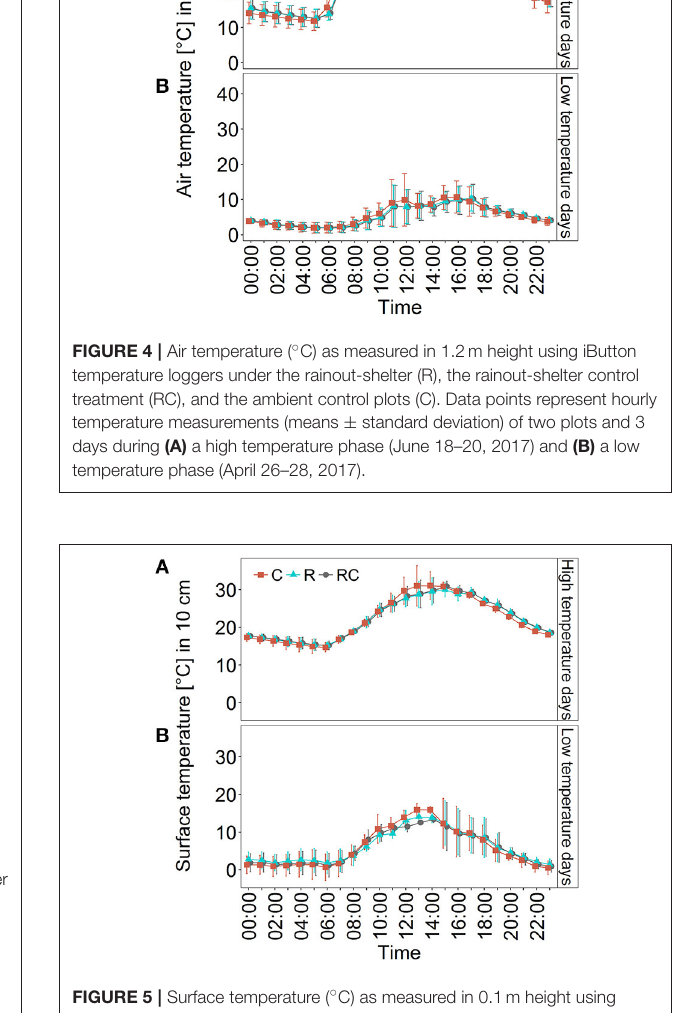
FIGURE 5 | Surface temperature ( ◦ C) as measured in 0.1m height using iButton temperature loggers under the rainout-shelter (R), the rainout-shelter control treatment (RC), and the ambient control plots (C). Data points represent hourly temperature measurements (means ± standard deviation) of one plots and 3 days during (A) a high temperature phase (May 28–30, 2017) and (B) a low temperature phase (April 18–20,